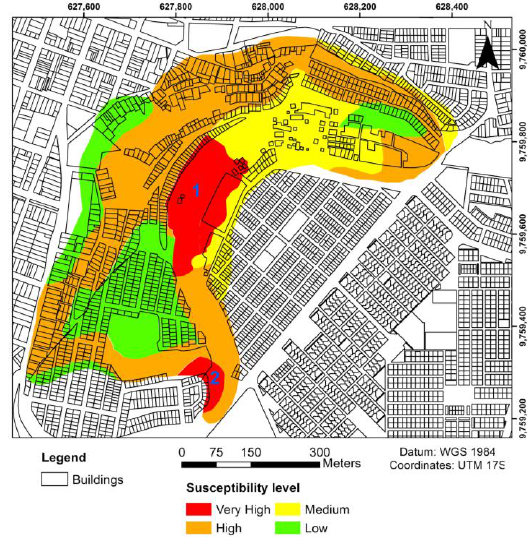
Figure 11. Housing and susceptibility zoning.